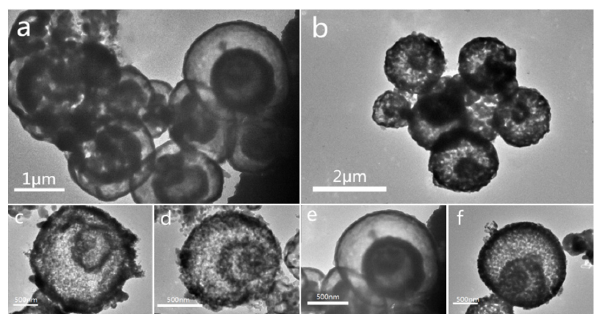
Figure 2. TEM images of hollow microsphere with different Ca/Fe molar ratio. ( a,e ) Ca80Fe20, ( b,f ) Ca75Fe25, ( c ) Ca90Fe10, ( d ) Ca85Fe15.